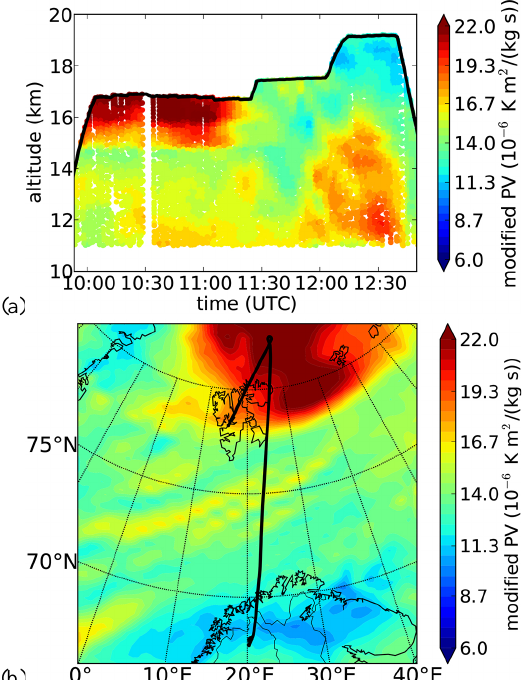
Fig. 1. CRISTA-NF cloud index for RECONCILE flight 11 (2 March 2010) as cross-section plot (a) and in longitude–latitude domain (b) . The solid black line shows the observer altitude in the cross-section plot and the observer location in the longitude-latitude plot. The turn of the aircraft is indicated by the white vertical stripe in the cross-section plot due to the lack of measurements during the turn.